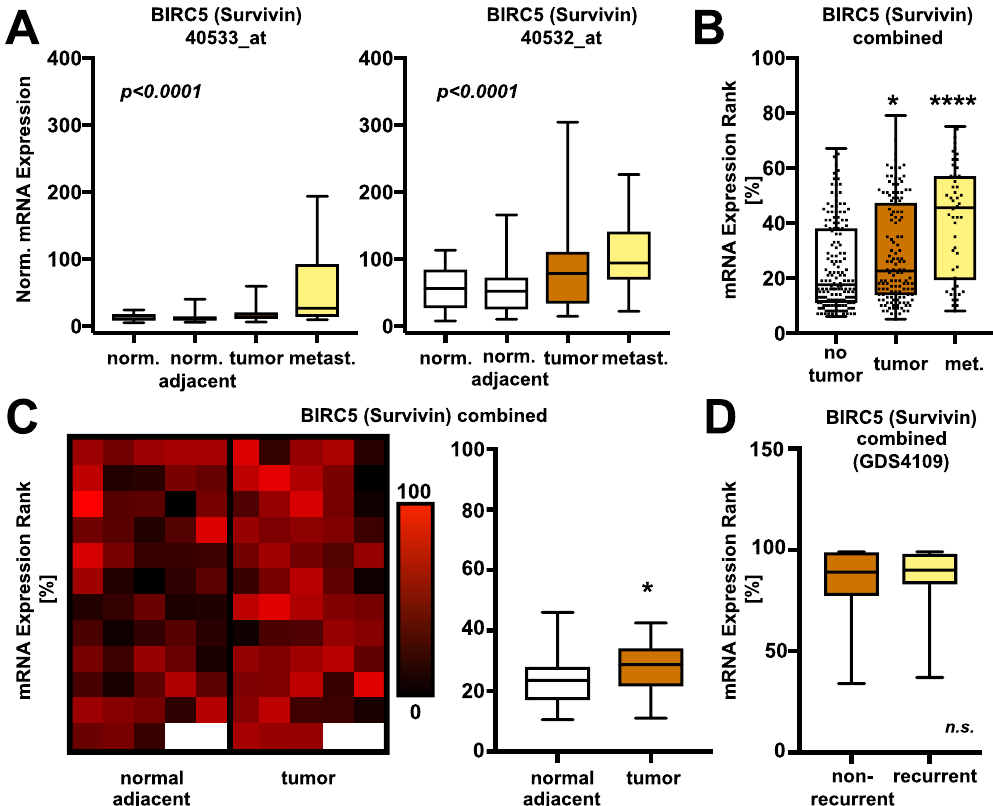
Figure 1. Survivin mRNA expression in healthy prostate tissues and prostate cancers. Gene expression analysis of two independent probes for BIRC5 (Survivin) shows higher BIRC5 mRNA expression in primary prostate cancers (tumor) and prostate cancer metastases (met.) compared with normal adjacent prostate tissues (norm. adjacent) and tissues from healthy donors (norm, n = 171, both ANOVA p < 0.0001; 50533_at:: normal vs. tumor: p = 0.4447, normal vs. metastasis: p < 0.0001, tumor vs. metastasis: p < 0.0001; 40532_at: normal vs. tumor: p = 0.0499, normal vs. metastasis: p = 0.0013, tumor vs. metastasis: p = 0.0277, Holm-Sidak posthoc analysis, ( A )). Combined expression ranks analysis reveals higher BIRC5 levels in prostate cancer samples (tumor, p < 0.05) and prostate cancer metastases (met., p < 0.0001) compared to cancer-free prostate samples (no tumor, B , all ANOVA with Holm-Sidak posthoc test). A heatmap of relative BIRC5 mRNA expression in prostate cancer tissue (tumor) and the surrounding adjacent normal prostate per individual patient (box) is shown ( C , left panel). Per individual patient, prostate cancers show higher BIRC5 mRNA expression than the corresponding adjacent tumor-free tissue ( C , right panel, p < 0.05, Wilcoxon matched-pairs signed rank test). BIRC5 expression did not differ in recurrent vs. non-recurrent prostate cancers ( D , p > 0.05, n = 39 vs. 40 patients, Mann-Whitney test). Standardized expression values and expression ranks were extracted from the identified GEO datasets GDS2545 and GDS4109 and compared as described in the Methods section with the statistical tests given in parenthesis (data are median ± range; * p < 0.05 vs. corresponding